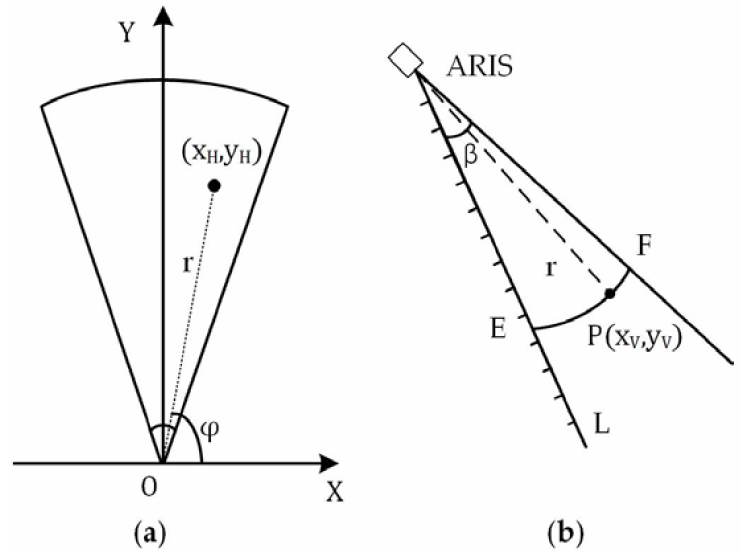
Figure 3. ( a ) Horizontal field of view of the sonar; ( b ) vertical field of view of the sonar. β is the angle of the vertical field of view, which is approximately 14 ◦